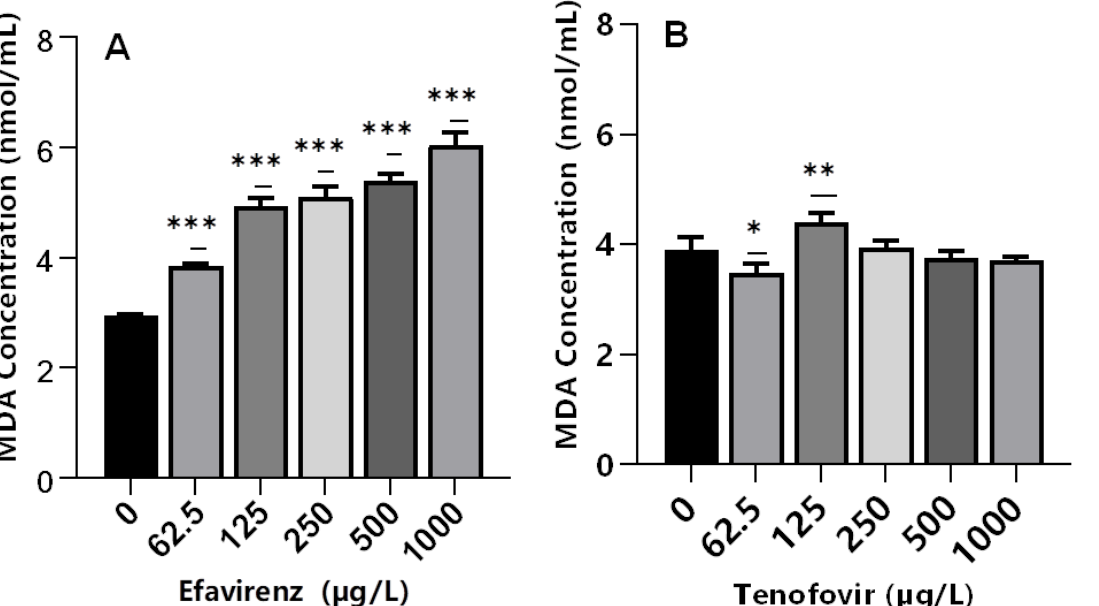
Figure 4. MDA levels in D. magna exposed to ( A ) EFV, and ( B ) TFV for 48 h. Values are presented as mean ± standard deviation ( n = 3); (Asterisks (*) denote significant differences (one-way ANOVA followed by Dunnett’s multiple comparisons test (* p < 0.05, ** p ≤ 0.01, *** p ≤ 0.001)) between ARVs - exposed samples and the controls.